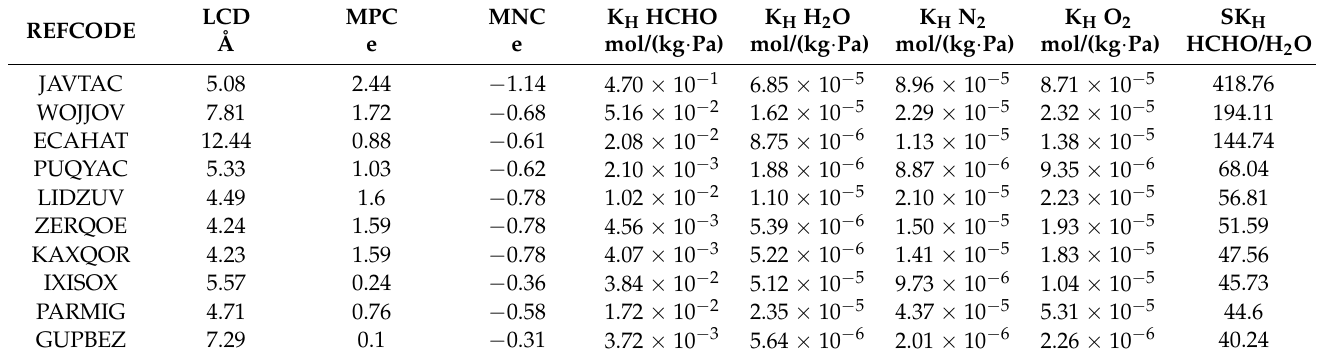
Table 2. The LCD, MPC, MNC, and K H of HCHO, H 2 O, N 2 , and O 2 for the top 10 MOFs in SK H HCHO/H 2 O.